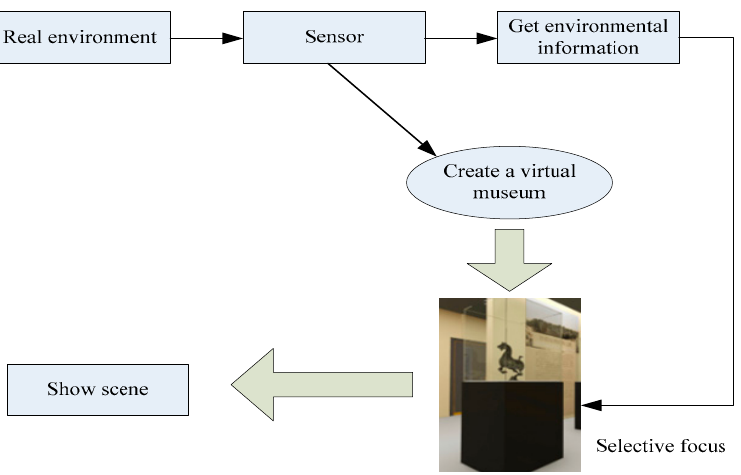
Figure 2. The process of applying augmented reality technology to digital museums.